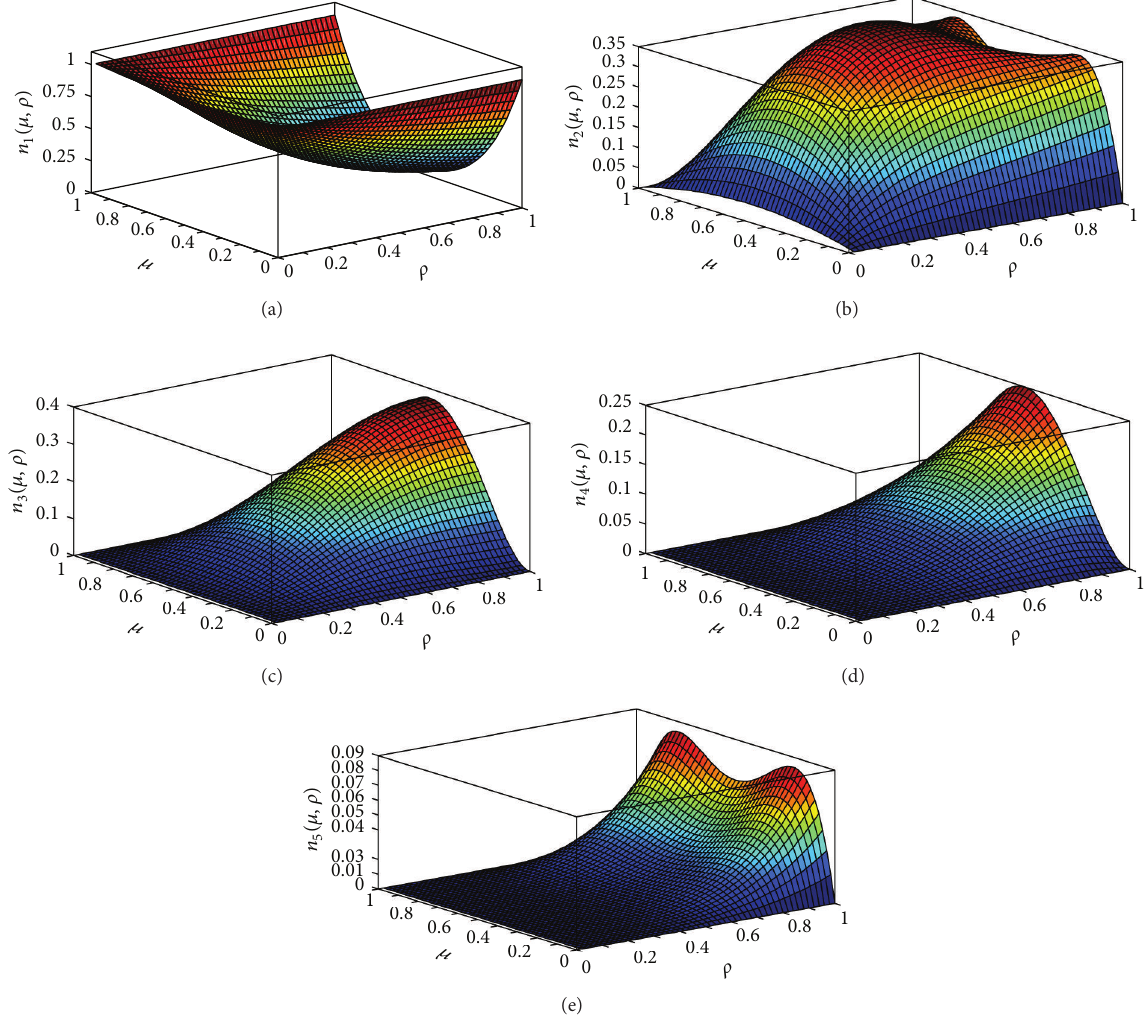
Figure 8: Relative fraction of players belonging to different ranks in dependence on 𝜇 and 𝜌 : (a) 𝑛 1 (𝜇,𝜌) ; (b) 𝑛 2 (𝜇,𝜌) ; (c) 𝑛 3 (𝜇,𝜌) ; (d) 𝑛 4 (𝜇,𝜌)